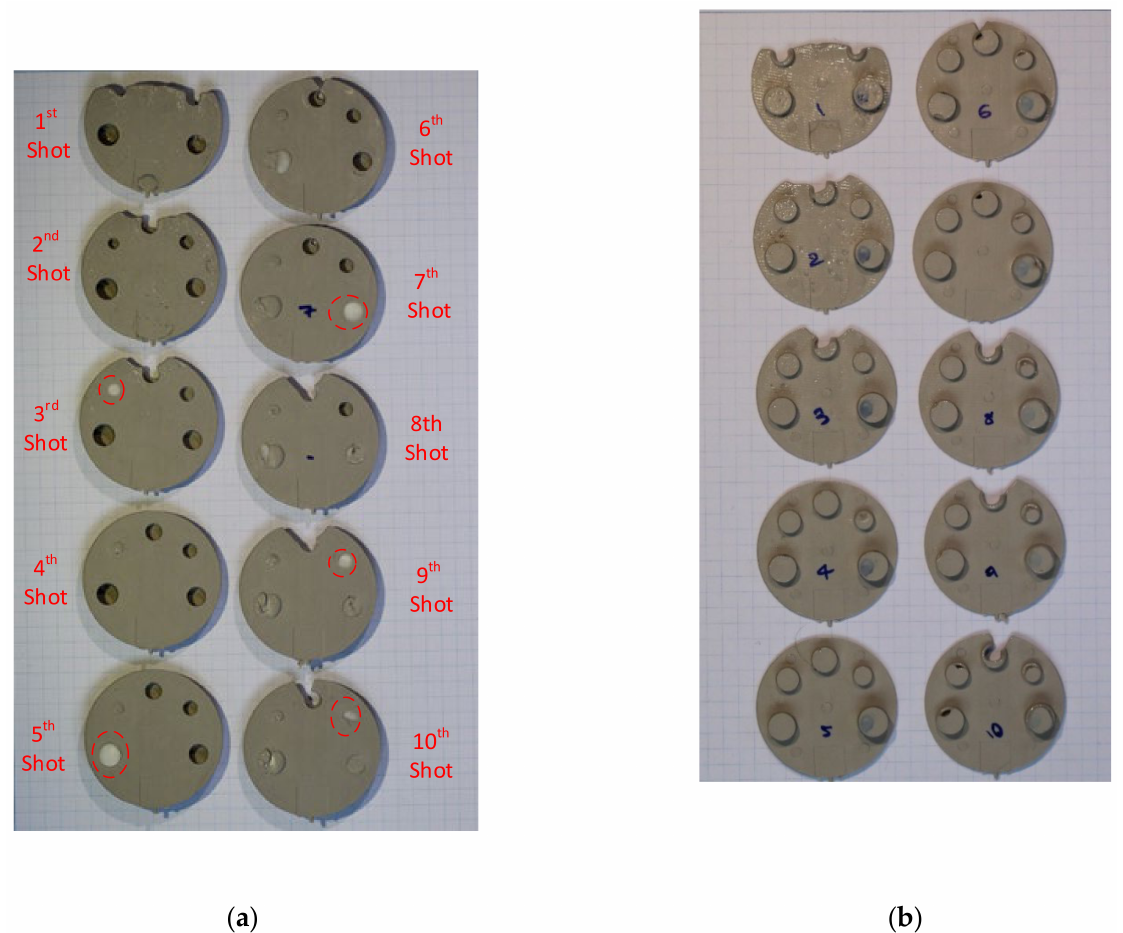
Figure 22. ( a ) Core face of the moulded part showing signs of progressive deterioration; ( b ) cavity side of the moulded showing no signs of progressive deterioration (moulded using insert A). The red circle highlights the area of interest and shows deterioration of the core pin (broken bits of core pin) after each